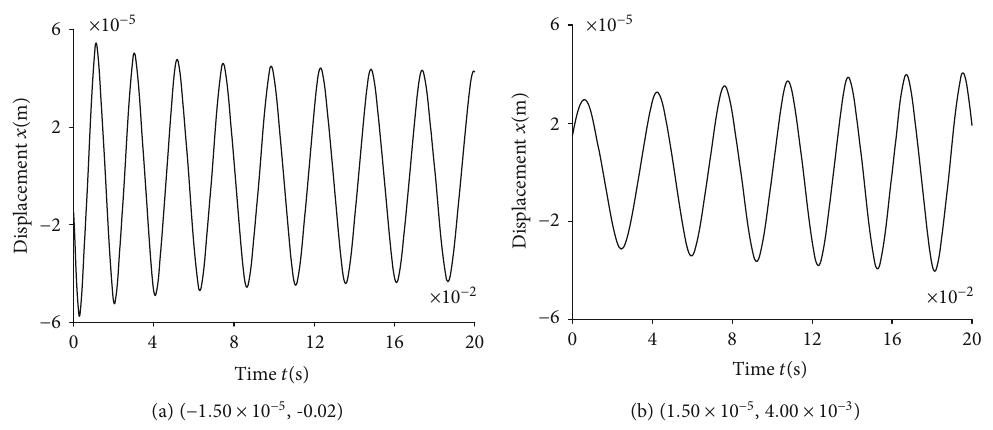
Figure 31: x − t curves under h